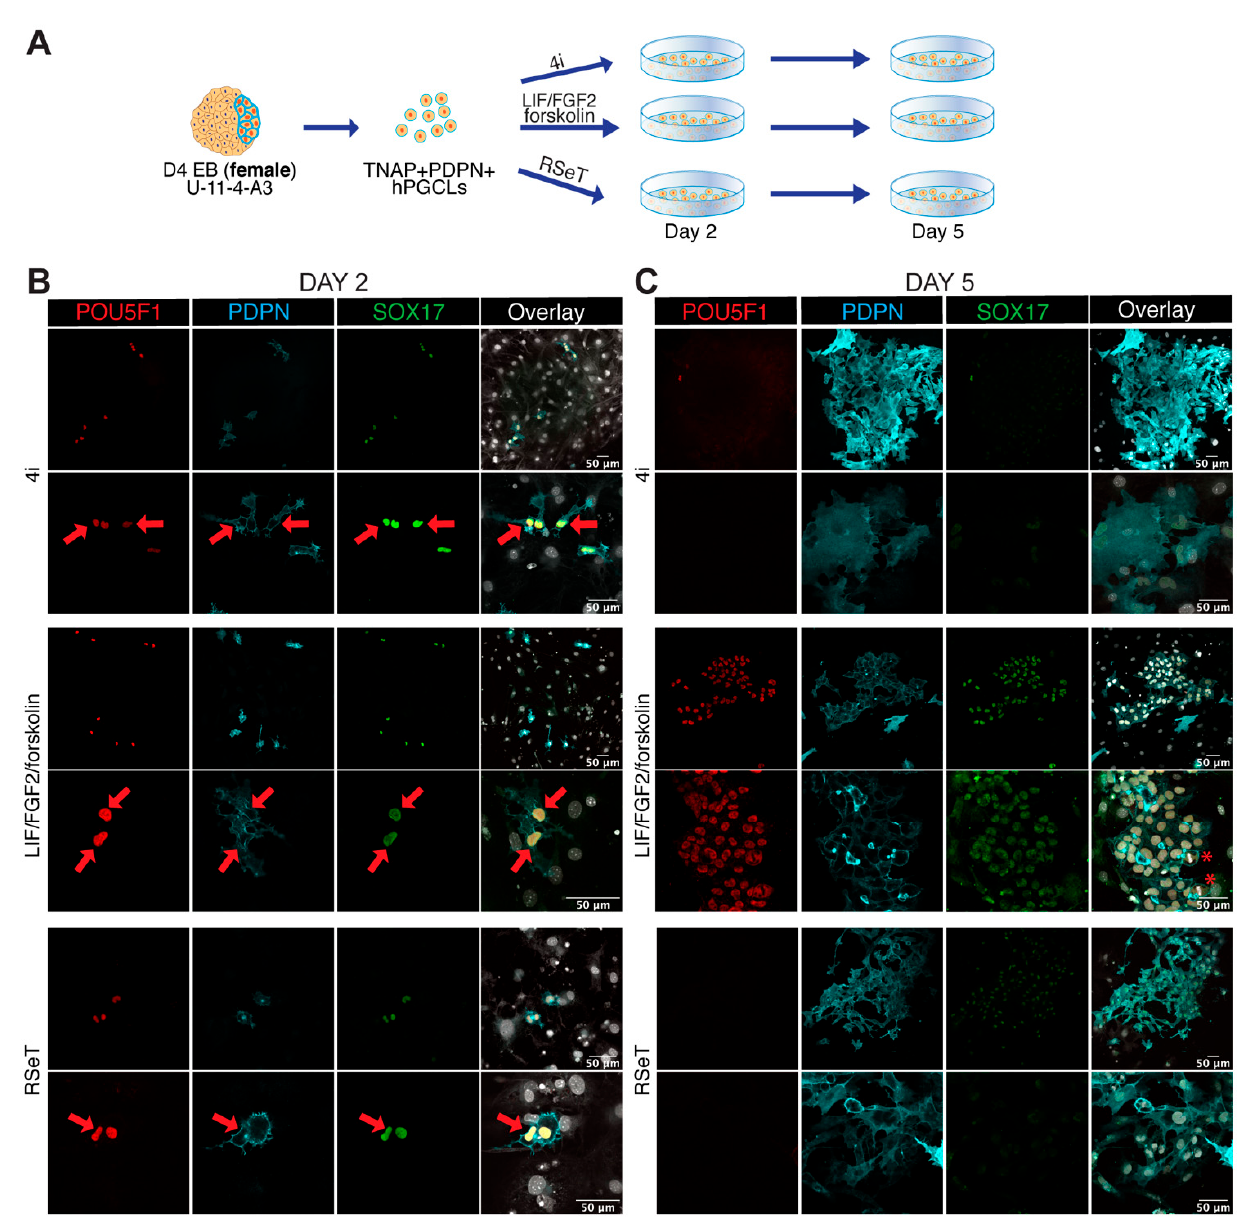
Figure 4. Evaluating the propagation of female hPGCLCs in vitro. ( A ) Scheme showing the extended culture protocol used of (female) TNAP+PDPN+ hPGCLCs FACS-isolated from D4 EBs and cultured in different media (4i, RSeT and LIF/FGF2/forskolin). ( B ) Images from day 2 of extended culture of female hPGCLCs in different media (4i, RSeT and LIF/FGF2/forskolin) immunostained for POU5F1, SOX17 and PDPN. Red arrows point to POU5F1+SOX17+PDPN+ hPGCLCs. Scale bars are 50 μ m. ( C ) Images from day 5 of extended culture of female hPGCLCs in different media (4i, RSeT and LIF/FGF2/forskolin) immunostained for POU5F1, SOX17 and PDPN. Red asterisks mark dividing cells. Scale bars are 50 μ m.